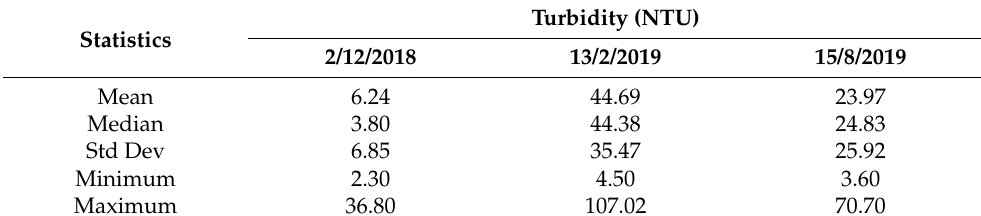
Table 2. Statistics of the acquired in situ turbidity measurements for all three dates.